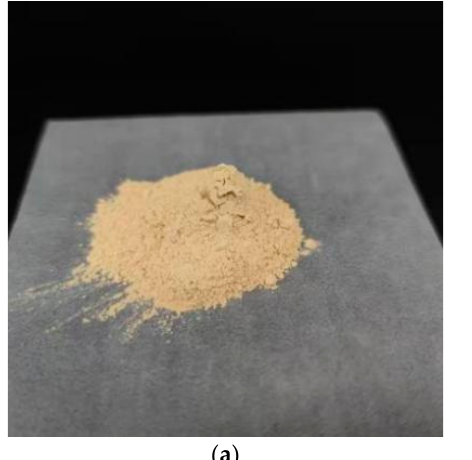
Figure 1. RIR powder ( a ); the supernatant solution of RIR-NaOH ( b ).